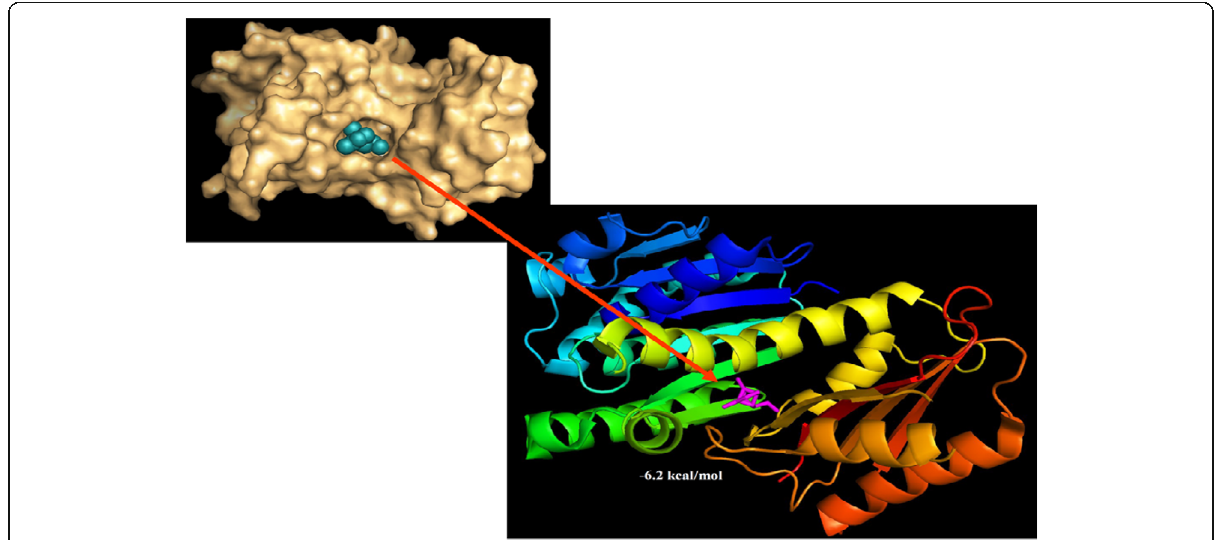
Fig. 7 Molecular docking of NF- κ B (PDB id INFK) with selected ligand